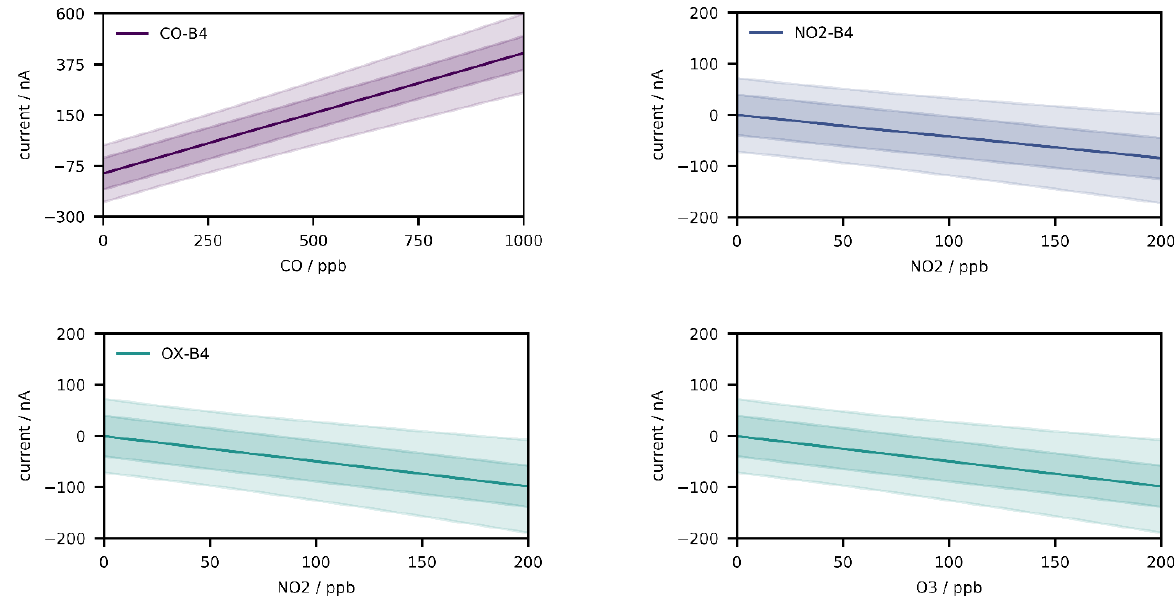
Figure 3. Distribution of the three sensor populations (q 0.50 , q 0.25–0.75 , q 0.05–0.95 ) with respect to zero (baseline) and sensitivity by exposure to 200 evenly spaced gas fractions (CO: 0–1000 ppb, NO 2 : 0–200 ppb, O 3 : 0–200 ppb) without mixing.